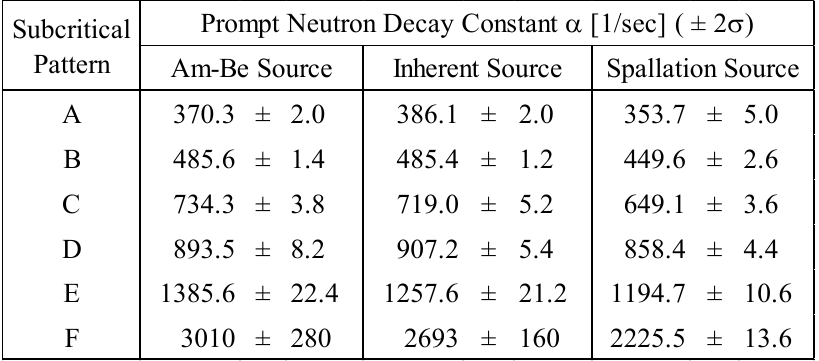
Table Ⅱ . Prompt decay constants determined by Feynman- α